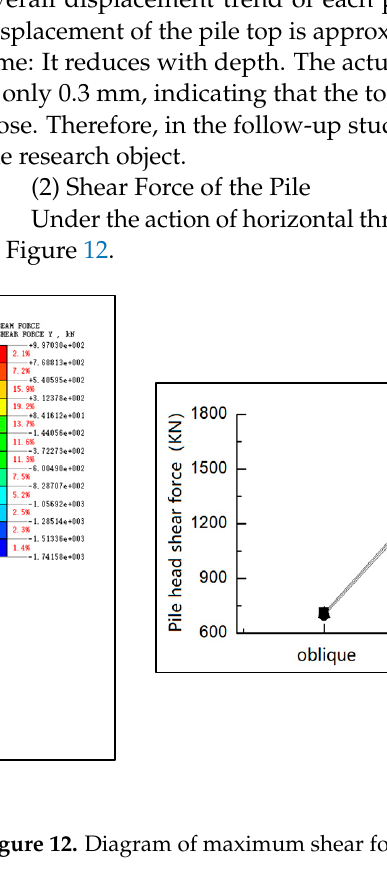
Figure 11. Piles group displacement behavior of the piles top.